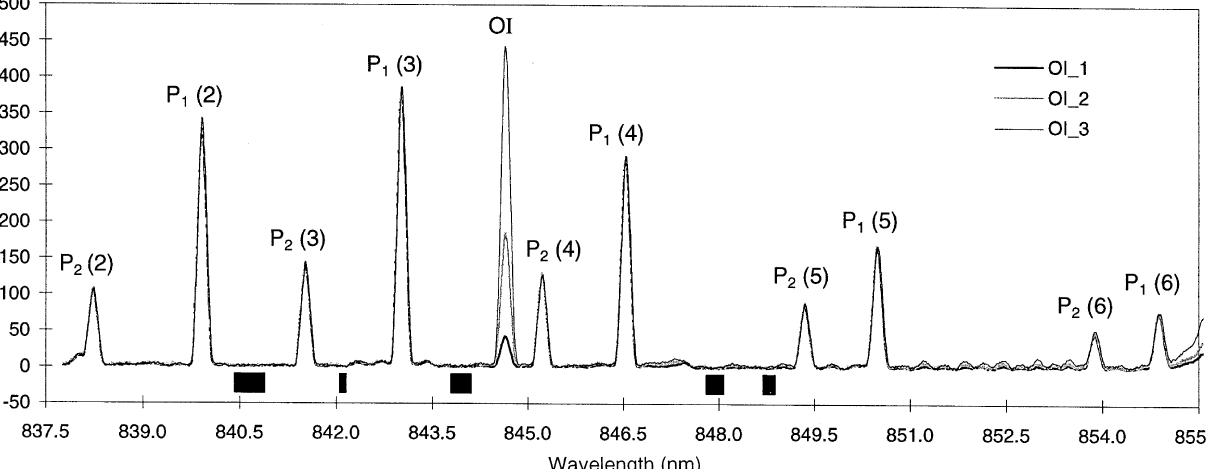
Fig. 1. Averaged and smoothed spectra of the OH(6–2) band region at three levels of auroral activity. Smoothing was applied with a filter of less than 0.02-nm half-width. Significant features are labelled and